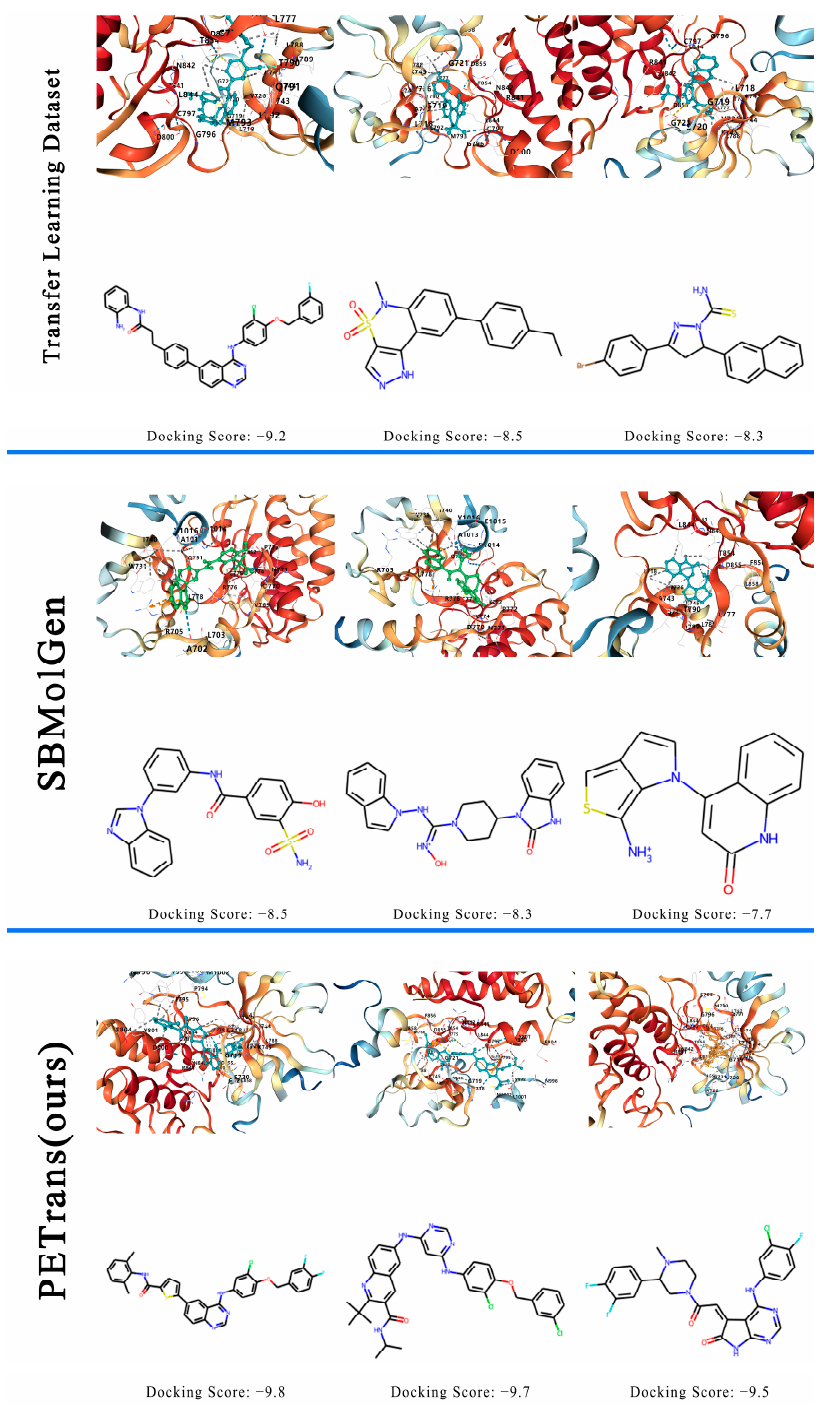
Figure 3. Three examples of molecules in different sets. The comparison of docking scores and binding models of molecules in the transfer learning dataset, SBMolGen and PETrans.